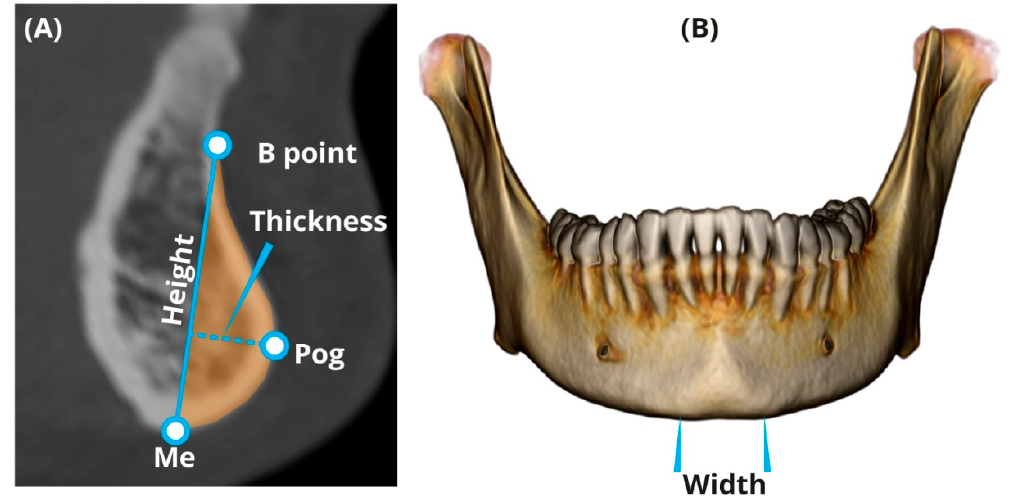
Figure 2. Measurements of the chin. ( A ) Height, thickness, and cross-sectional area (CSA) (in light orange); Me—menton, Pog—pogonion. ( B ) Chin width.